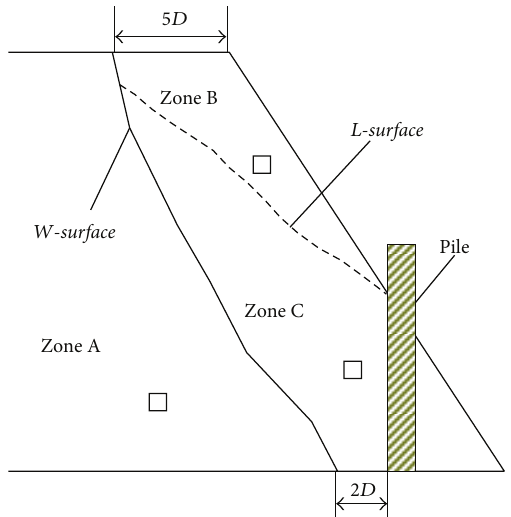
Figure 13: Division of zones with different features. D : pile